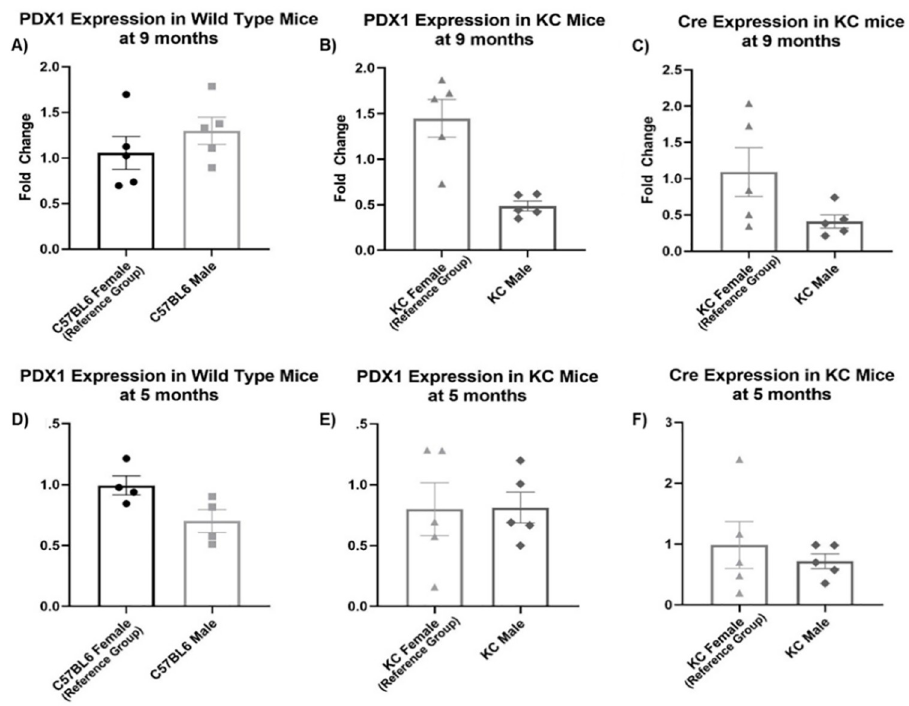
Fig 4. Pdx1 expression and Cre-recombinase expression in mouse anus. Anal tissue was excised from male and female wild type mice and male and female KC mice at 9 and 5 months of age. mRNA was isolated and RT-PCR performed to evaluate for Pdx1 and Cre -recombinase expression. Male and female C57BL/6J WT mice demonstrate Pdx1 expression in anal tissue at both 5 and 9 months, as did male and female KC mice (A, B, D, E). At 9 months age, KC females express significantly higher amounts of Cre mRNA (C) due to the presence of tumor tissue. At 5 months, male and female KC mice express similar amounts of Pdx1 and Cre mRNA (E,